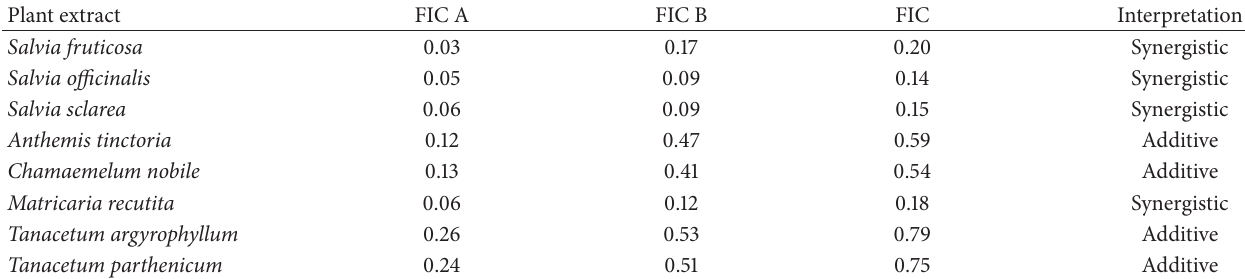
Table 3: Interactions of plant extracts and oxacillin in effect on methicillin-resistant S. epidermidis Sep6.